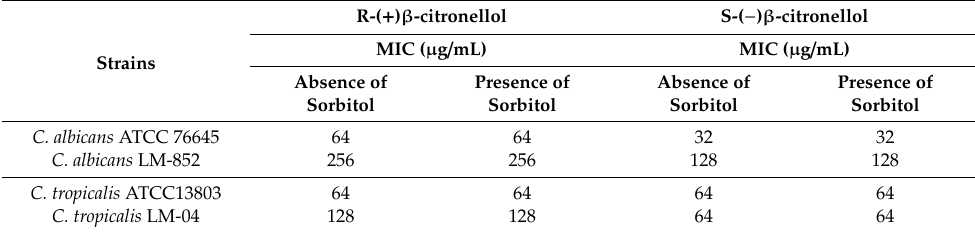
Table 3. E ff ect of R-( + )- β -citronellol and S-( − )- β -citronellol on the strains of C. albicans (ATCC-76645 and LM-852) and C. tropicalis (ATCC-13803 and LM-04) in the absence and presence of sorbitol 0.8 M.